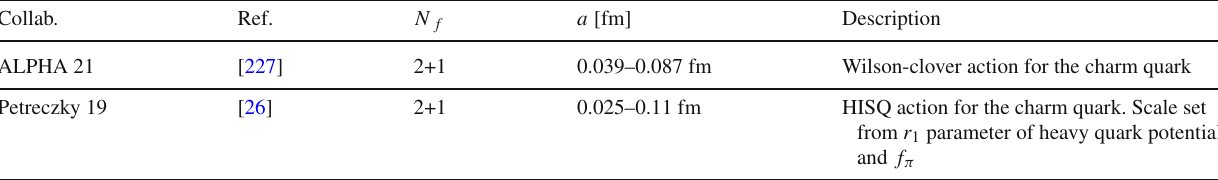
Table 88 Continuum extrapolations/estimation of lattice artifacts in the determinations of m c with N f = 2 + 1 quark flavours Collab.